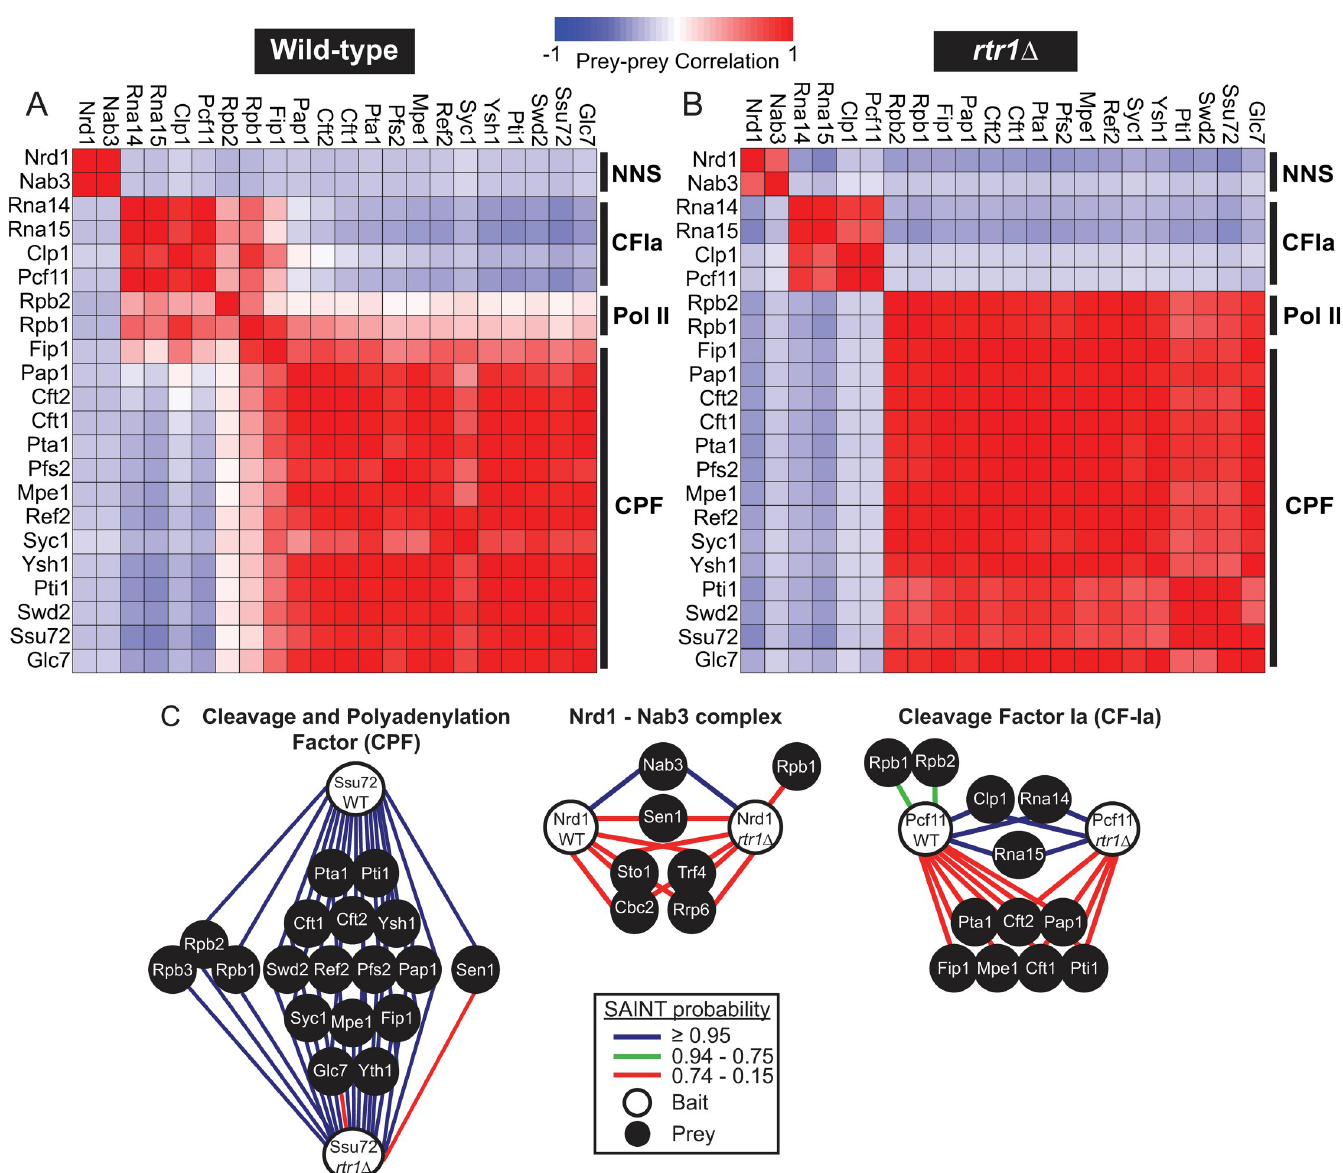
Fig 1. DisCo network analysis of complexes involved in RNAPII transcription termination in WT and rtr1 Δ yeast. A) Prey-prey correlation analysis of yeast termination complex affinity purification-mass spectrometry data from WT cells of n = 4 biological replicate purifications for each bait protein (Nrd1, Pcf11, and Ssu72, total n = 12). B) Prey-prey correlation analysis of yeast termination complex affinity purification-mass spectrometry data from rtr1 Δ cells of � 4 biological replicate purifications for each bait protein (Nrd1, Pcf11, and Ssu72, total n = 12). C) Ssu72-FLAG, Pcf11-TAP and Pcf11-FLAG, and Nrd1-TAP protein-protein interaction networks from WT and rtr1 Δ cells depicting SAINT analysis of n = 4 biological replicate purifications for each genotype. The nodes represent a protein of interest whereas the edges represent the SAINT interaction probability as indicated in the legend. Each protein-protein interaction network represents a subset of the full protein-protein interaction network which is shown in the supplement with a fold-change cutoff value of 5 for each WT purification (S1 Fig). https://doi.org/10.1371/journal.pgen.1008317.g001 CPF-CF1a-RNAPII complex for stable 3’-end complex formation and mRNA polyadenylation [27]. However, in cells lacking the CTD phosphatase Rtr1, the cross-correlation between the CFIa complex and CPF complex subunits Fip1 and Pap1 is markedly reduced (Fig 1B). In addition, the correlation between CFIa and RNAPII is also reduced, suggesting that deletion of RTR1 leads to reduced interactions between Pcf11, the bait protein for CFIa, and RNAPII.